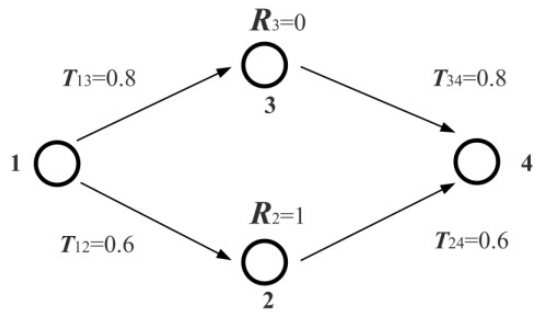
Figure 2. An example of WSNs ( w T = 0.6, w R = 0.4). Table 1. Possible social trust path and corresponding state vector in Figure 2.